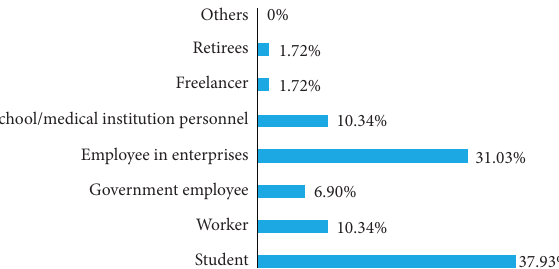
Figure 1: Occupational distribution of respondents.